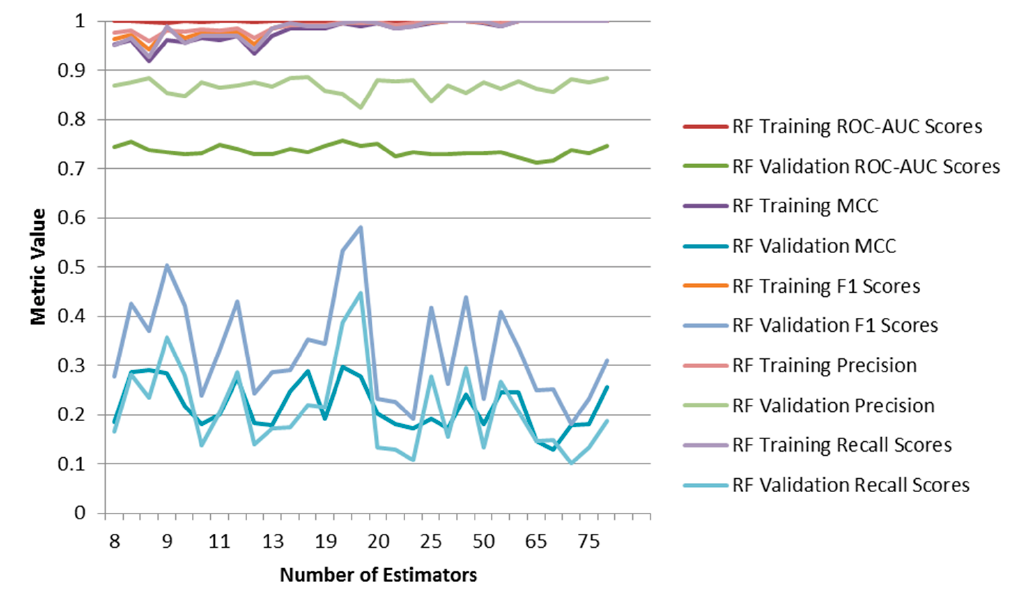
Figure 4. Metrics for different Random Forest models with varying number of epochs. MCC = Matthews correlation coefficients for balanced training test and validation test.